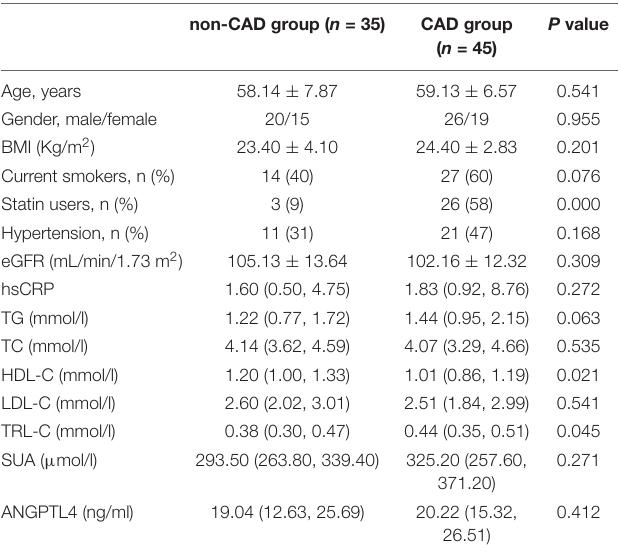
TABLE 2 | Clinical characteristics of the CAD group and non-CAD group.